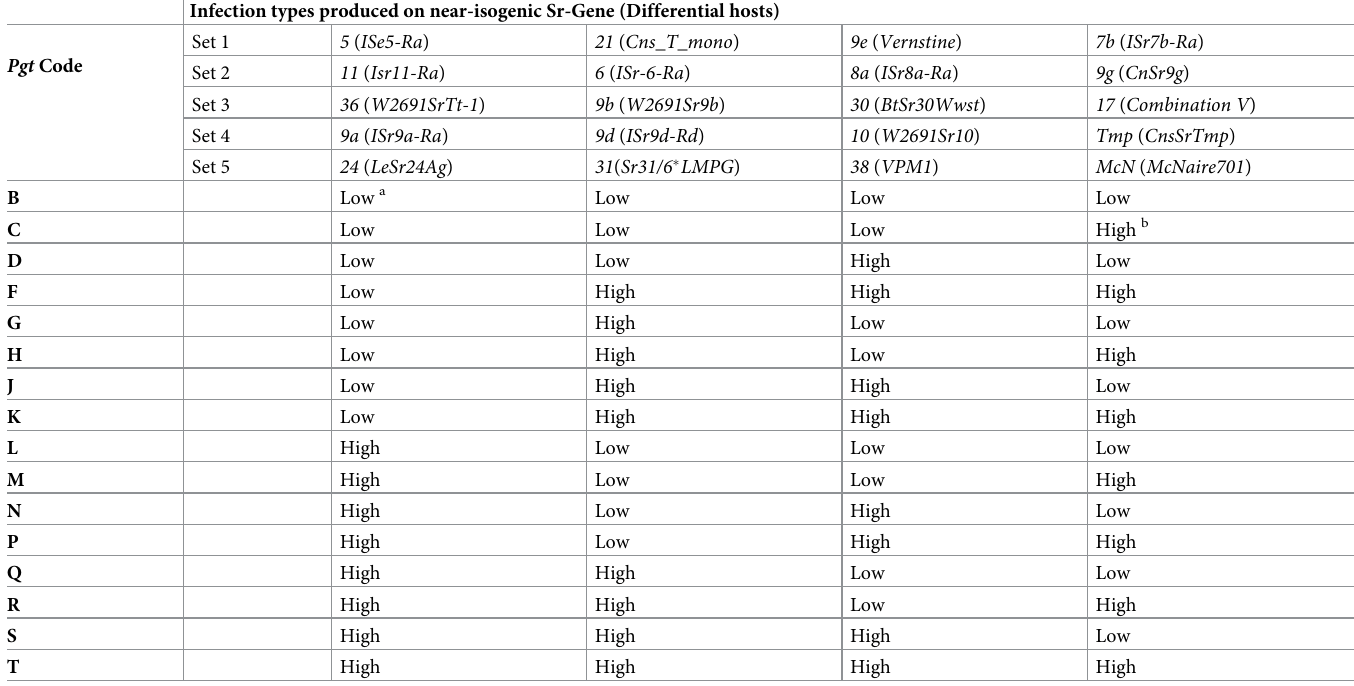
Table 2. Wheat stem rust differentials and nomenclature of Pgt based on 20 �� wheat hosts. Infection types produced on near-isogenic Sr-Gene (Differential